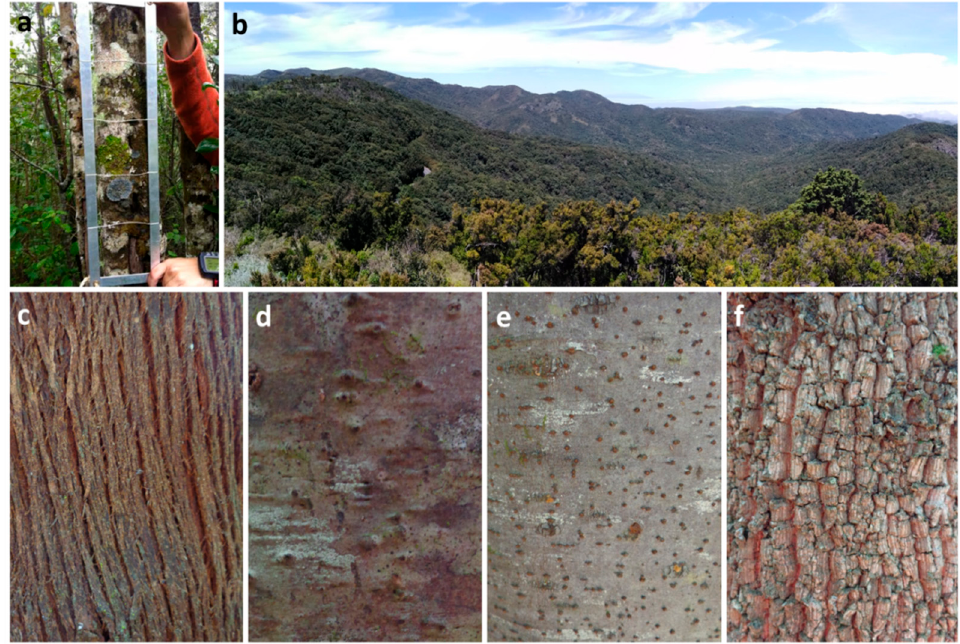
Figure 2. ( a ): Sampling methodology: frame on laurel forest’s tree. ( b ): Laurel forest in La Gomera Island. ( c – f ): Tree bark of Erica canariensis ( c ), Ilex canariensis ( d ), Laurus novocanariensis ( e ), and Morella faya ( f ).